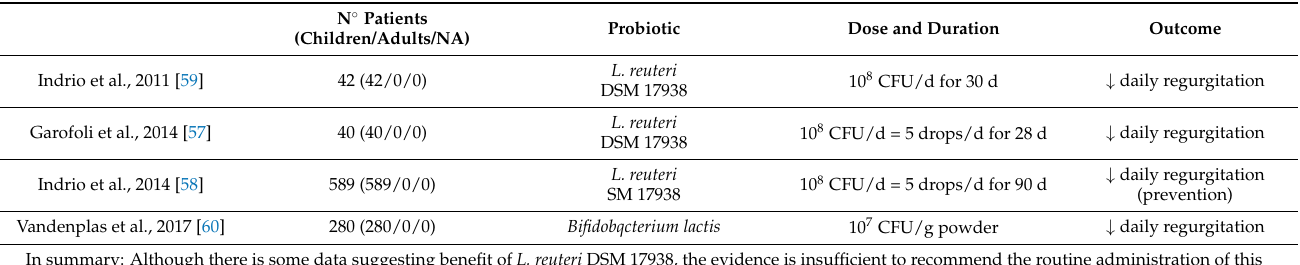
Table 7. Randomized controlled trials on probiotics in